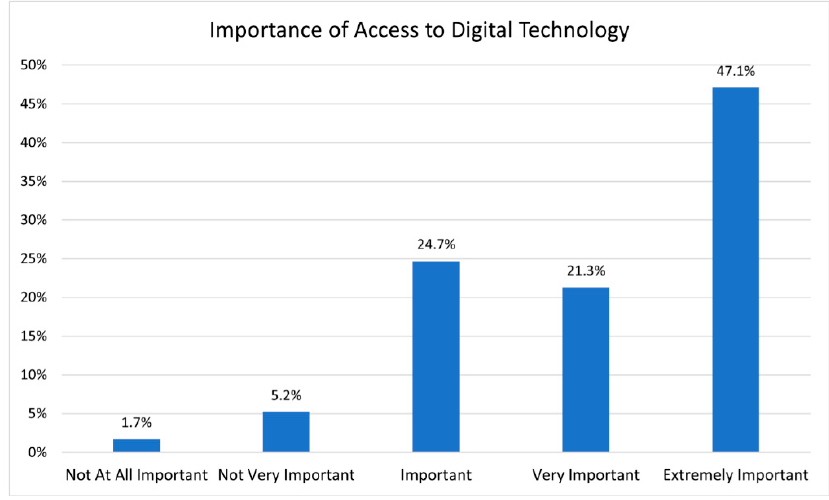
Figure 3. Importance of access to digital technology.